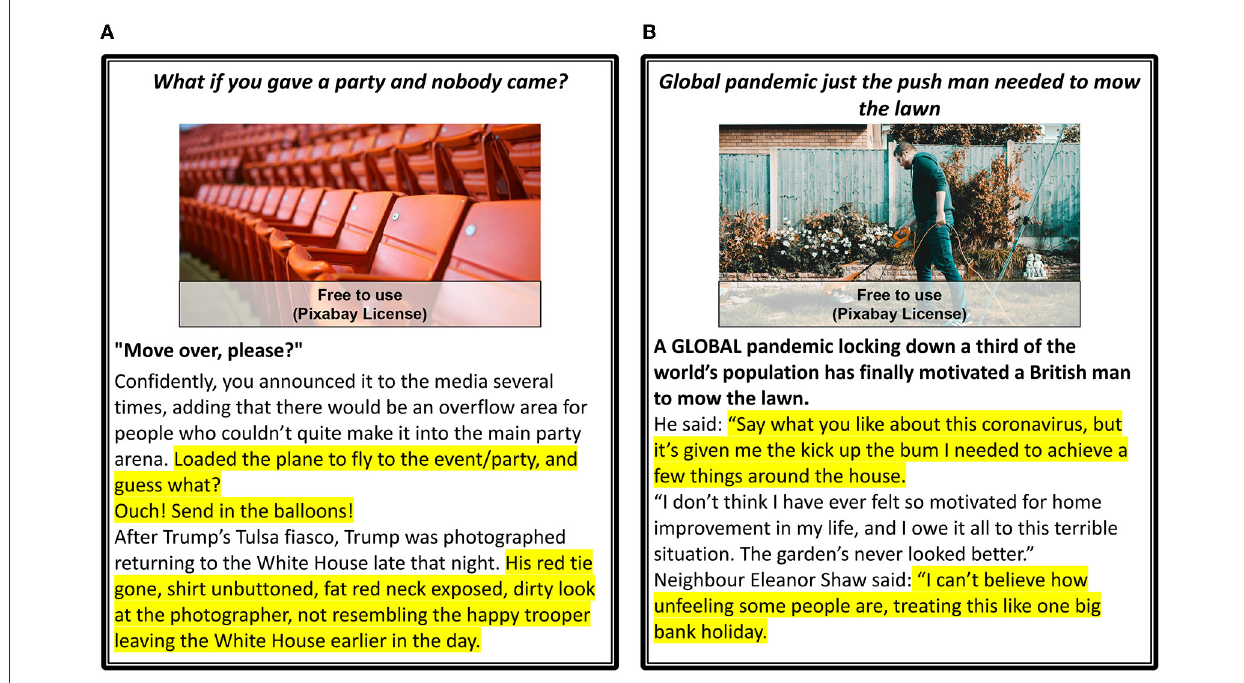
FIGURE4 Author Intent examples: Entertaining and Opinions. The portions of the text (entertaining, satirical parts, or quotes) that lead to the assignment of corresponding categories are highlighted (yellow). (A) Entertaining. (B) Entertaining & Opinions.